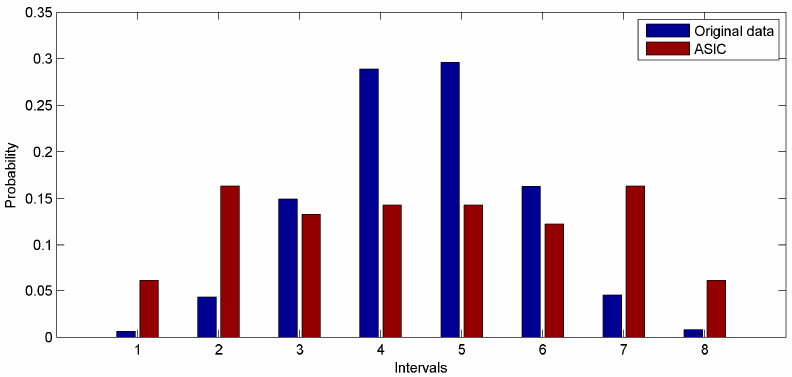
Figure 8. Comparison of distributions of data collected from synthetic dataset.